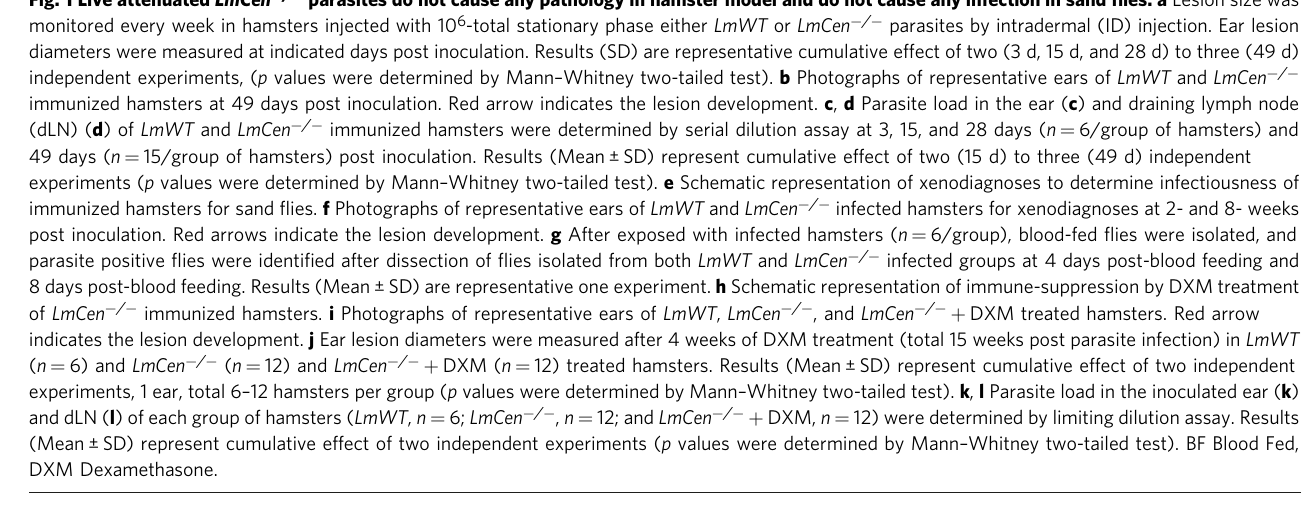
Fig. 1 Live attenuated LmCen − / − parasites do not cause any pathology in hamster model and do not cause any infection in sand fl ies. a Lesion size was monitored every week in hamsters injected with 10 6 -total stationary phase either LmWT or LmCen − / − parasites by intradermal (ID) injection. Ear lesion diameters were measured at indicated days post inoculation. Results (SD) are representative cumulative effect of two (3 d, 15 d, and 28 d) to three (49 d) independent experiments, ( p values were determined by Mann – Whitney two-tailed test). b Photographs of representative ears of LmWT and LmCen − / − immunized hamsters at 49 days post inoculation. Red arrow indicates the lesion development. c , d Parasite load in the ear ( c ) and draining lymph node (dLN) ( d ) of LmWT and LmCen − / − immunized hamsters were determined by serial dilution assay at 3, 15, and 28 days ( n = 6/group of hamsters) and 49 days ( n = 15/group of hamsters) post inoculation. Results (Mean ± SD) represent cumulative effect of two (15 d) to three (49 d) independent experiments ( p values were determined by Mann – Whitney two-tailed test). e Schematic representation of xenodiagnoses to determine infectiousness of immunized hamsters for sand fl ies. f Photographs of representative ears of LmWT and LmCen − / − infected hamsters for xenodiagnoses at 2- and 8- weeks post inoculation. Red arrows indicate the lesion development. g After exposed with infected hamsters ( n = 6/group), blood-fed fl ies were isolated, and parasite positive fl ies were identi fi ed after dissection of fl ies isolated from both LmWT and LmCen − / − infected groups at 4 days post-blood feeding and 8 days post-blood feeding. Results (Mean ± SD) are representative one experiment. h Schematic representation of immune-suppression by DXM treatment of LmCen − / − immunized hamsters. i Photographs of representative ears of LmWT , LmCen − / − , and LmCen − / − + DXM treated hamsters. Red arrow indicates the lesion development. j Ear lesion diameters were measured after 4 weeks of DXM treatment (total 15 weeks post parasite infection) in